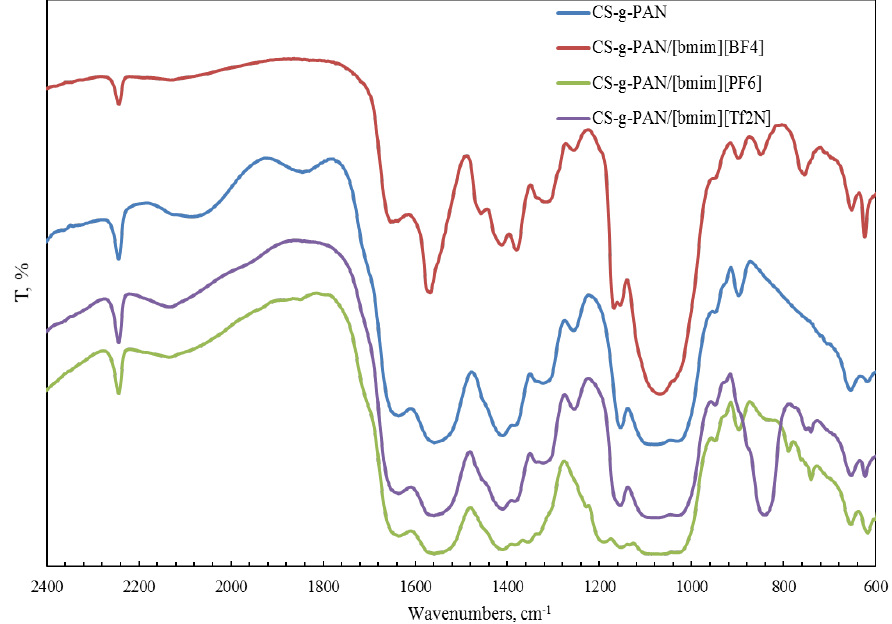
Figure 3. FTIR spectra of pure CS-g-PAN copolymer and CS-g-PAN copolymers doped with IL.